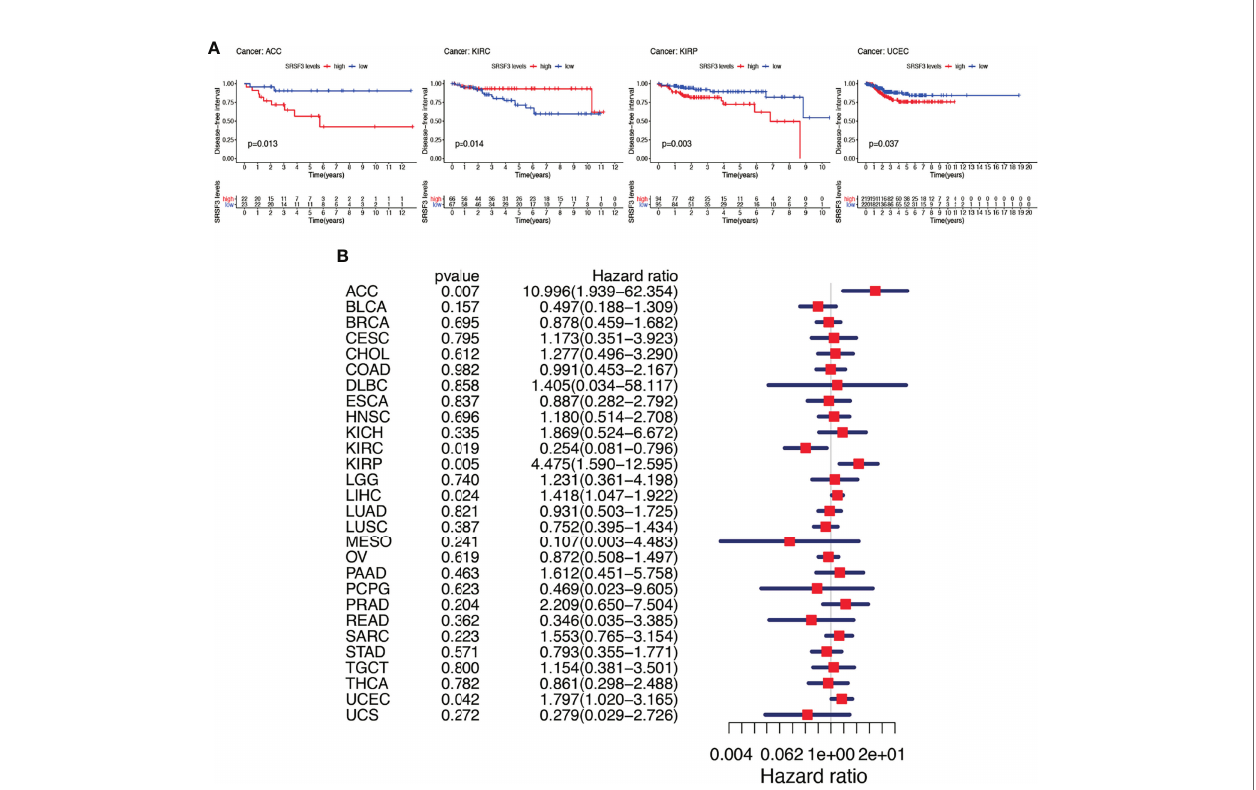
FIGURE 5 | Between DFI and the expression of SRSF3 among human pan-cancer. (A) DFI difference between high and low SRSF3 expression groups (divided by median expression values) in signi fi cant prognosis-related tumors from TCGA database. DFI difference between groups in ACC. DFI difference between groups in KIRC. DFI difference between groups in KIRP. DFI difference between groups in UCEC. (B) Association between expression levels of SRSF3 and DFI in different tumors from TCGA database. P < 0.05 is considered to be statistically signi fi